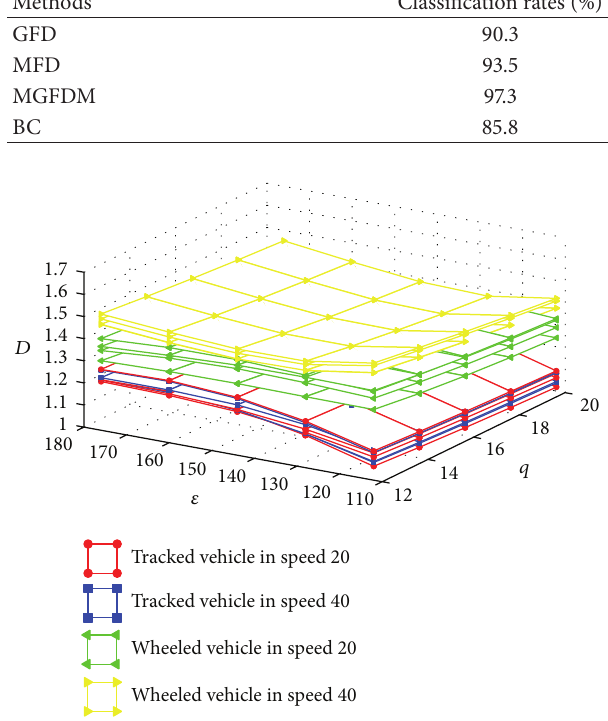
Figure 4: MGFDM of tracked vehicle and wheeled